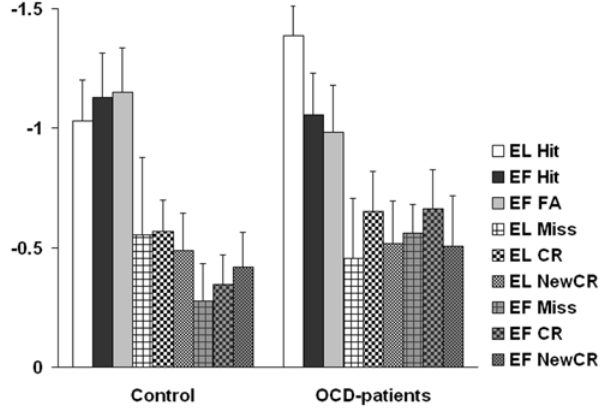
Figure 3. Mean amplitudes of the ERN. Bar graphs of mean ERP amplitudes at electrode sites Fz and Cz (0–100 ms after response) for the control groups (left) and OCD group (right).